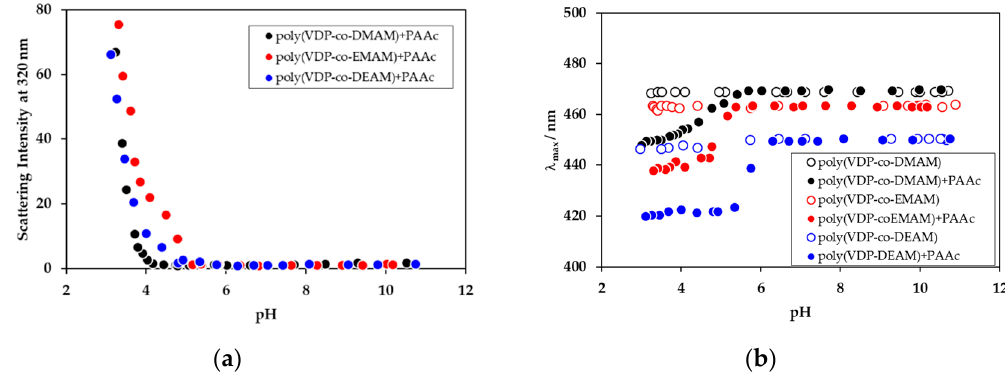
Figure 6. Scattering intensity at 320 nm and fluorescence λ max values of the mixed solutions of poly(VDP- co -acrylamide derivatives) and polyAAc, as a function of pH.